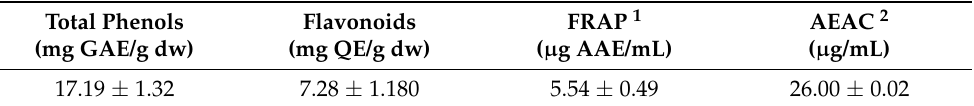
Table 1. Total phenols, flavonoids content, and antioxidant capacity (FRAP assay and electrochemical method) of SM extract *.